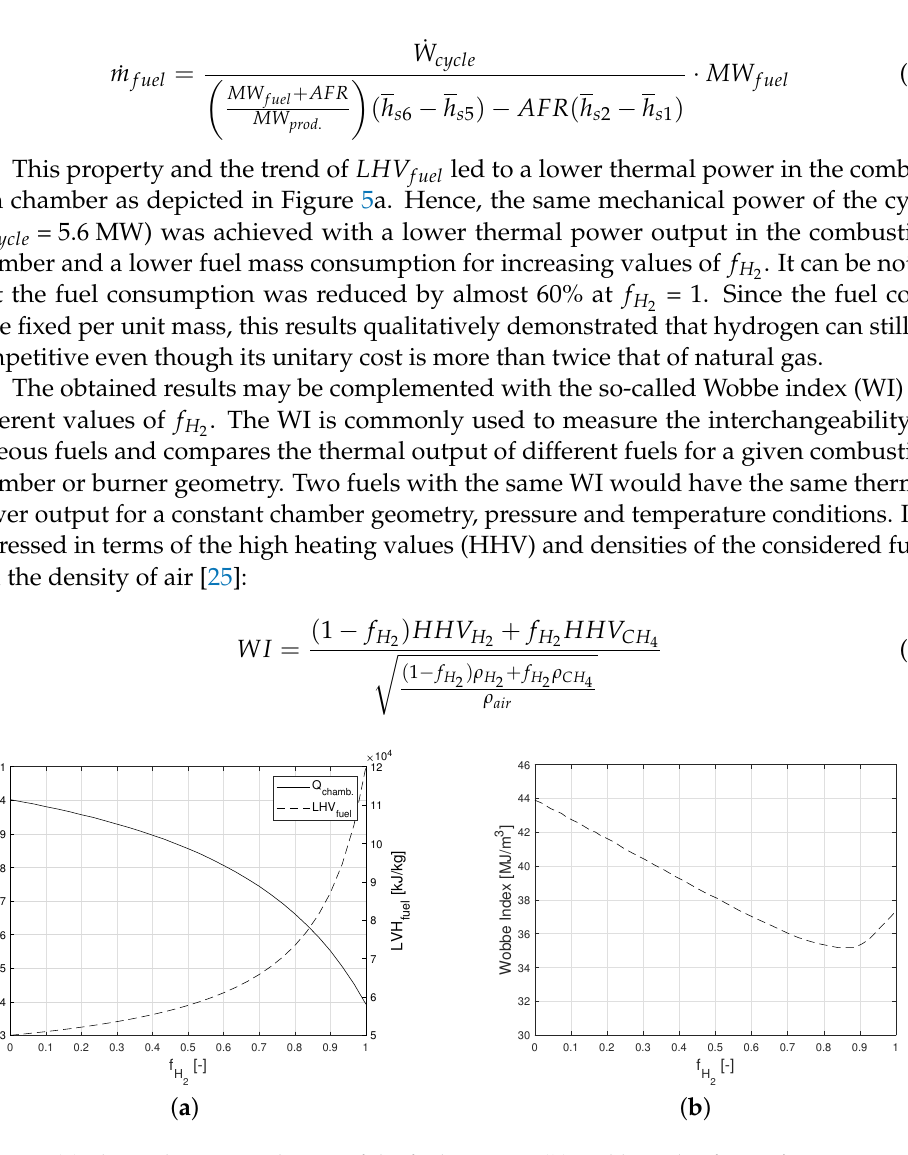
Figure 5. ( a ) Thermal power and LHV of the fuel mixture. ( b ) Wobbe index for H 2 /CH 4